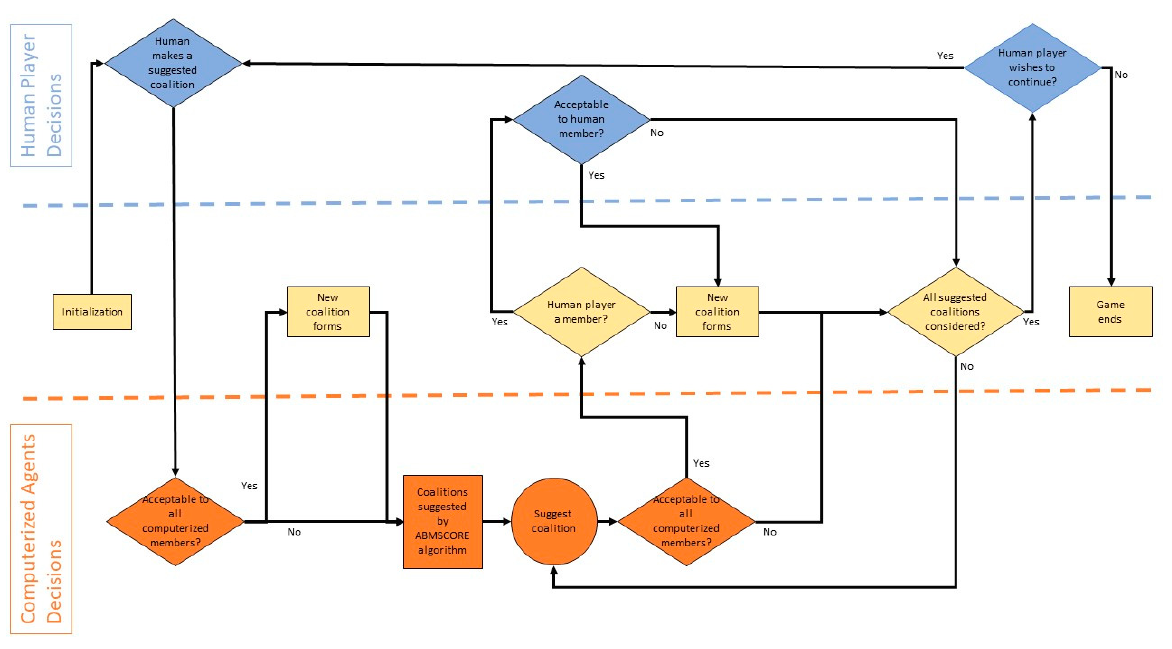
Figure 2. Flow diagram of decision processes in the model.